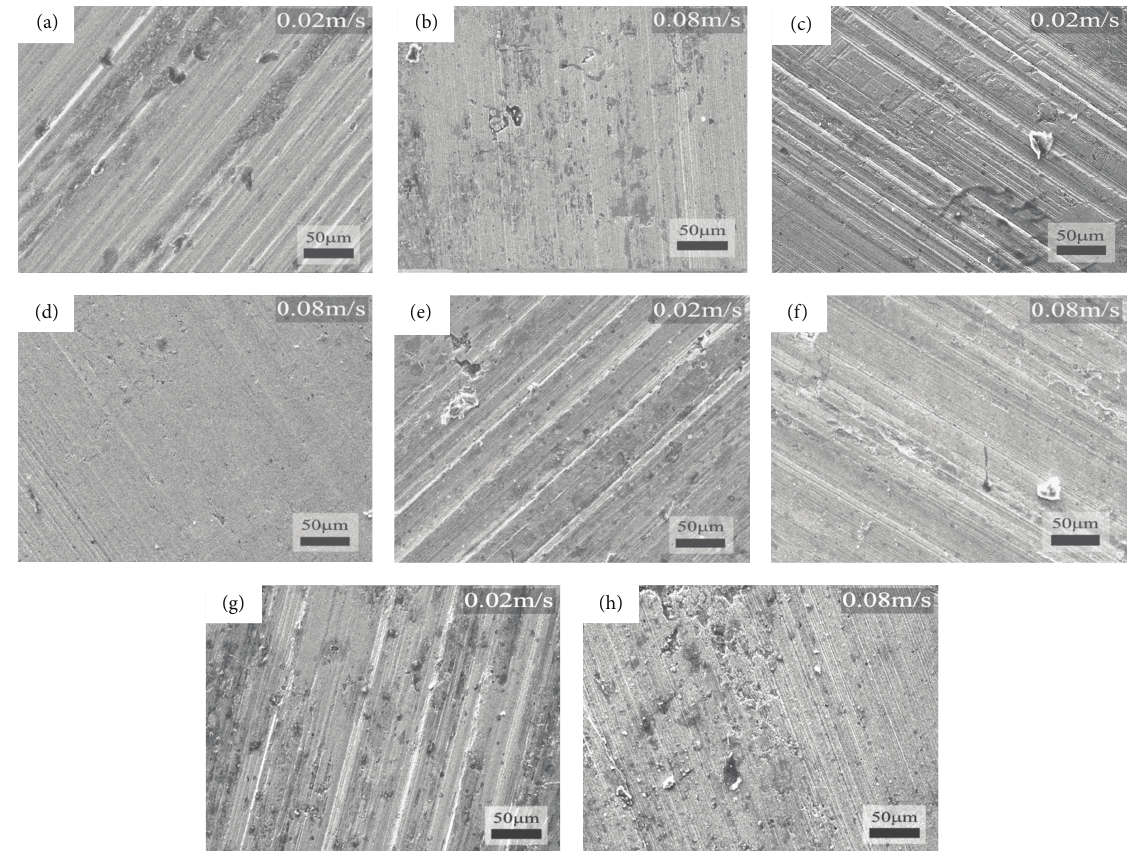
Figure 2: SEM micrographs of the worn surfaces of NC 10 (a) and (b); NC 20 (c) and (d); NC 40 (e) and (f); CG (g) and (h) under speed of 0.02 m/s and 0.08 m/s,